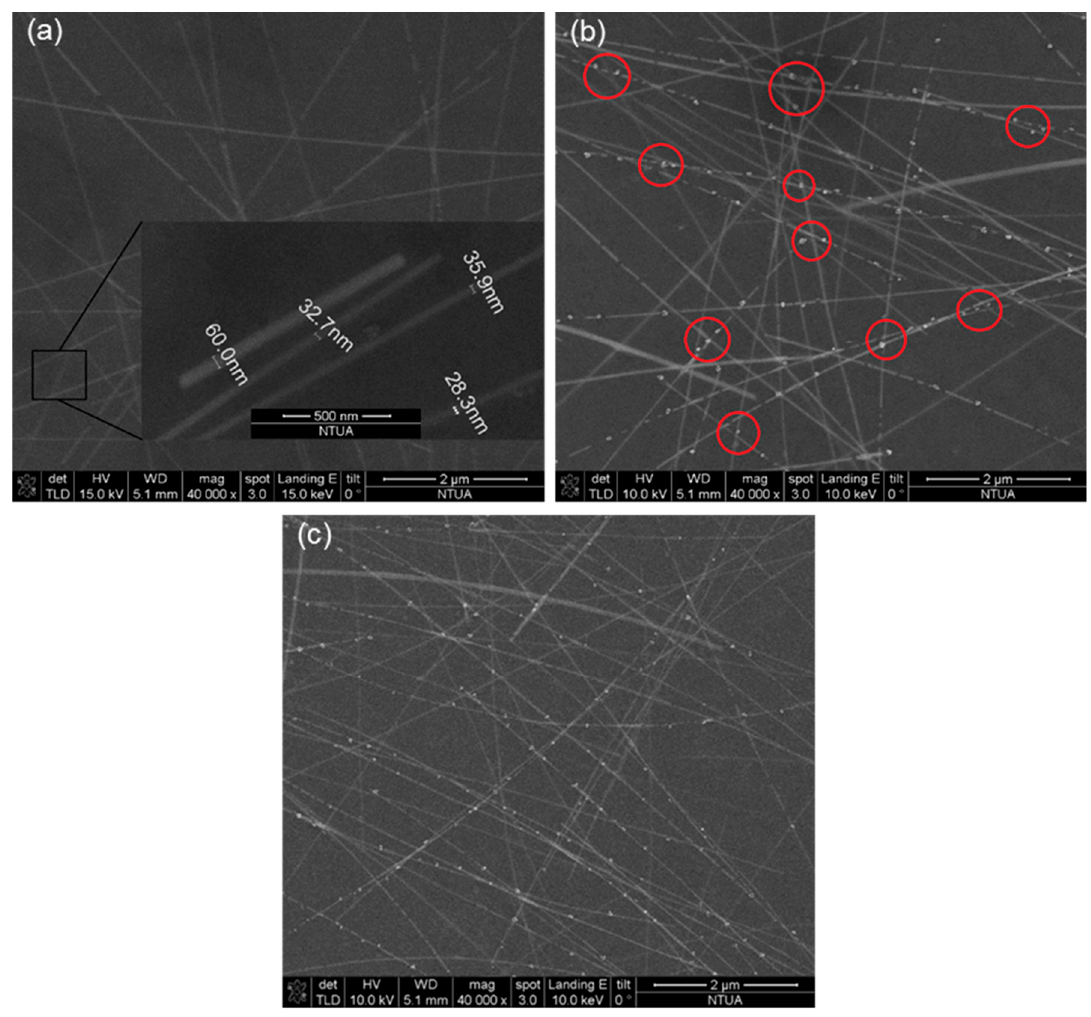
Figure 6. SEM micrographs Ag NW networks: ( a ) Spin coated layer on PEN; ( b ) Laser transferred pixel with curing effect. Fused NW-NW junctions showing balling are marked in red circles. ( c ) Oven cured Ag NW network, with a slightly increased density of fused junctions.